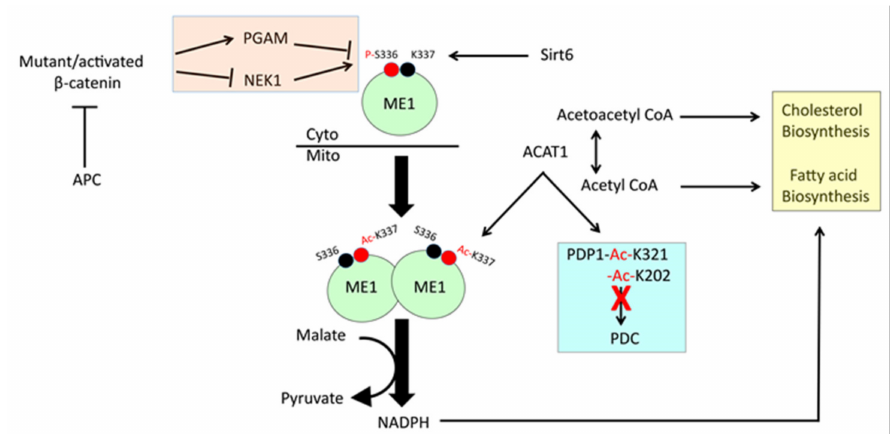
Figure 4. Regulation of ME1 by mutually exclusive phosphorylation and acetylation of adjacent residues. ME1 is normally maintained in an inactive, phosphorylated and non-acetylated cytoplasmic state via the balance between PGAM and NEK1 and the deacetylation activity of cytosolic Sirt6, respectively (post-translationally unmodified or modified residues are indicated by red and black small circles, respectively). Activation of β -catenin, either directly via mutation or indirectly via APC loss, alters the ratio between pro-oncogenic PGAM and tumor suppressor NEK1 so as to favor ME1 S336 dephosphorylation, ME1 (cid:48) s translocation into the mitochondria and its ACAT1-mediated acetylation on K337. This in turn allows for ME1 homo-dimerization/tetramerization and the activation of its intrinsic enzymatic activity, which, while catalyzing the conversion of malate to pyruvate, generates NADPH that supports both fatty acid and cholesterol biosynthesis. ACAT1- mediated inhibitory acetylation of the PDP1 phosphatase inhibits PDC activity, allowing for the accumulation of pyruvate and other glycolytic intermediates, stimulating the Warburg effect and, in conjunction with increased lipid biosynthesis, promoting tumor